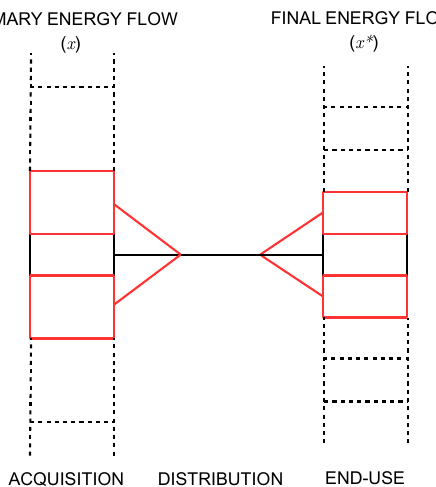
Figure 4. A schematic 1-D representation of the global RADE sys- tem. Here units of primary energy, x , are linked to those of final energy, x ∗ , via a distribution network. The black outlined system represents the initial stage of the systems evolution. The red out- lined system represents the subsequent addition of units of final en- ergy use and hence primary energy use and hence the expansion of the network linking the